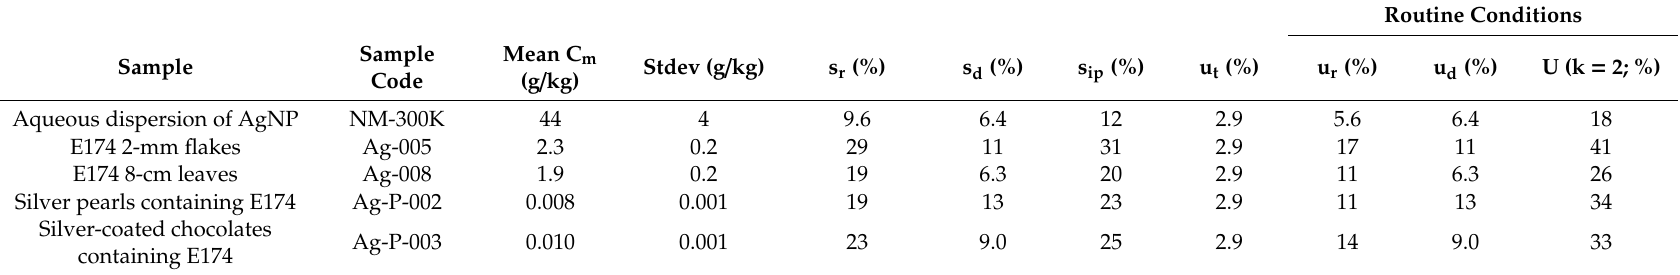
Table 3. Mean particle mass concentrations (C m ) and their associated standard deviation, repeatability (s r ), between-day variation (s d ) and intermediate precision (s ip ). Contributions of the trueness uncertainty (u t ), within-day (u r ), and between-day (u d ) uncertainty to the expanded uncertainty (U) on the measurement of the particle mass concentration by spICP-MS under routine measurement conditions (3 replicates × 1